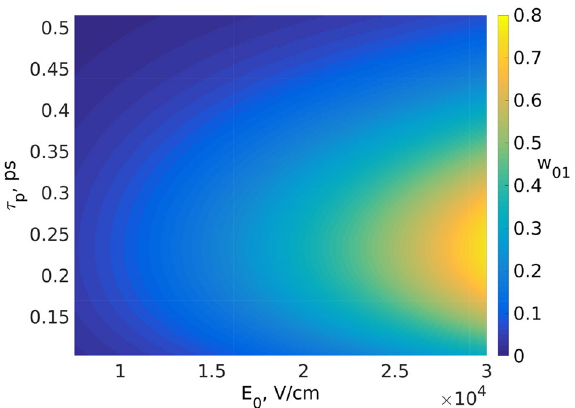
Figure 2. Dependence of the population of the 1st excited state w 01 on the pulse duration τ p and the amplitude E 0 calculated for H 2 O molecule. Other parameters: (cid:31) was created with Matlab R2016b (www.mathw